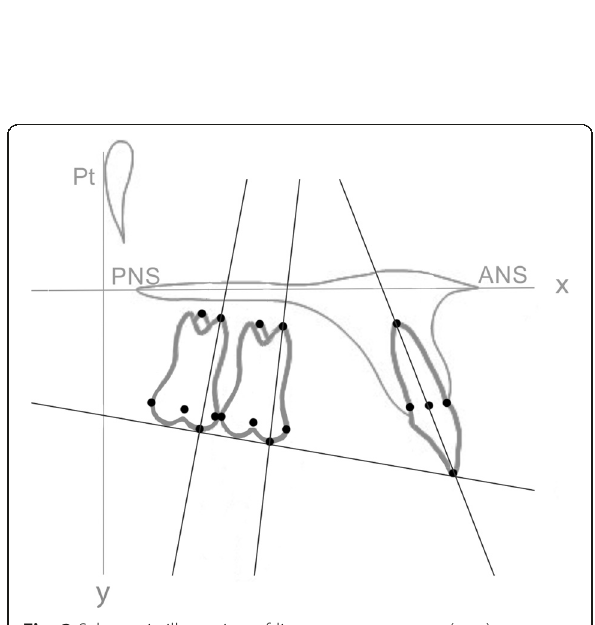
Fig. 3 Schematic illustration of linear measurements (mm) considered in the study. Horizontal measurements were expressed by the distance between the following points and the y axis (a perpendicular line to the palatal plane passing through the Ricketts ’ Pt point); second molar horizontal distance from the center of the crown, from the mesiobuccal cusp, from the mesiobuccal root ’ s apex, from the palatal root ’ s apex; first molar horizontal distance from the center of the crown, from the mesiobuccal cusp, from the mesiobuccal root ’ s apex, from the palatal root ’ s apex; central incisor distance; central incisor edge distance, central incisor radicular apex distance. Vertical distances were expressed by the distance between the same points and the x axis (palatal plane) and between the occlusal plane (except for incisor edge point and mesiobuccal cusp point, both tangential the occlusal